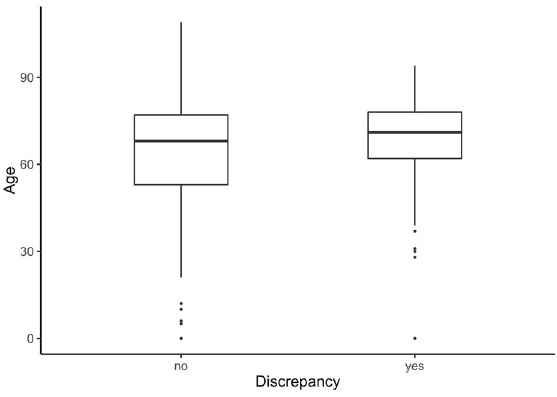
Fig 1. The Box-plot above compares age to discrepancy